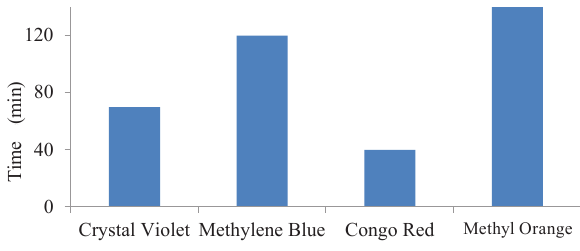
Fig 3: Absorbance of Congo red at different contact time Figure 6 Contact time of different dyes at dye concentration Figure 3 Absorbance of congo red at different contact time